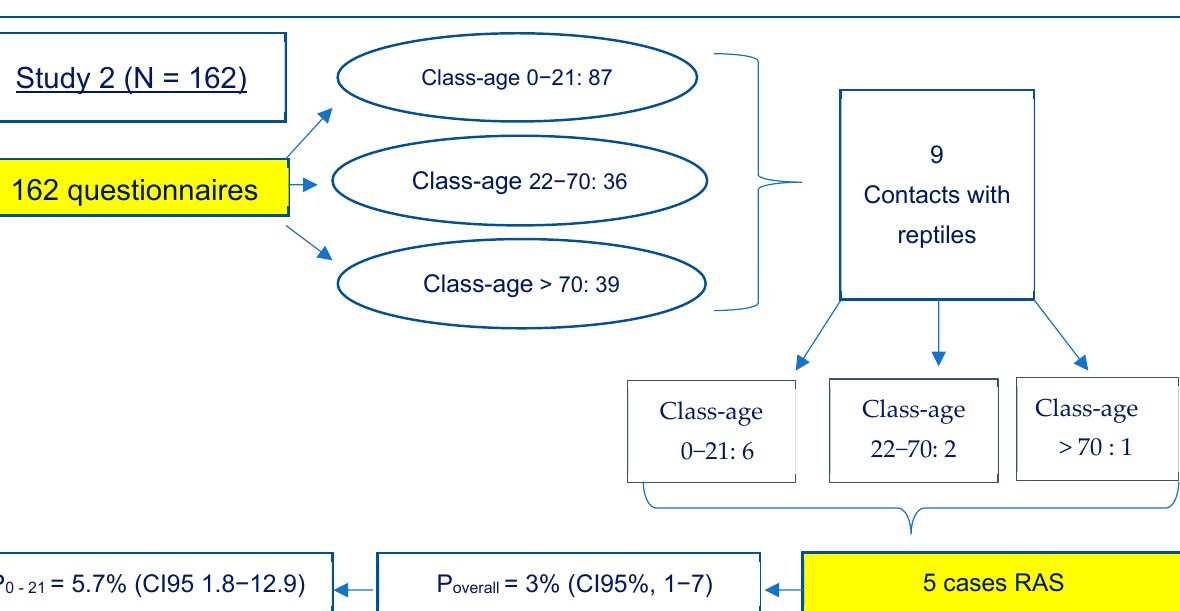
Figure 1. Results of the study carried out at the Hospital “Città della Salute e della Scienza” of Turin, Italy.